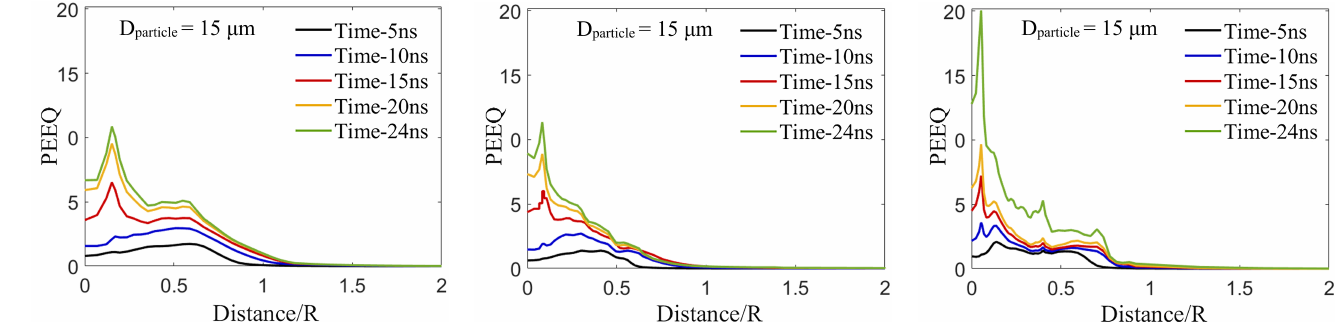
Figure 10. The time-evolved localized plastic deformation (PEEQ) over the contact-surface between the Al substrate and the B 4 C particle in the Al substrate for different particle diameters of 15, 25, and 40 µ m at a fixed impact velocity (500 m/s) on the Al substrate without a